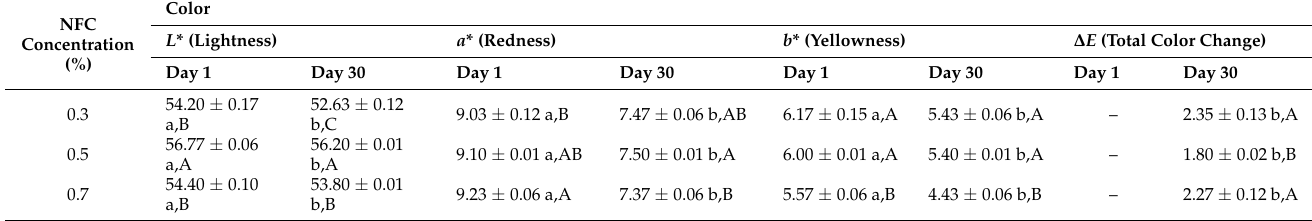
Table 2. Color ( L *, a *, b *) of AX-loaded emulsions measured after 1 and 30 days of storage at room